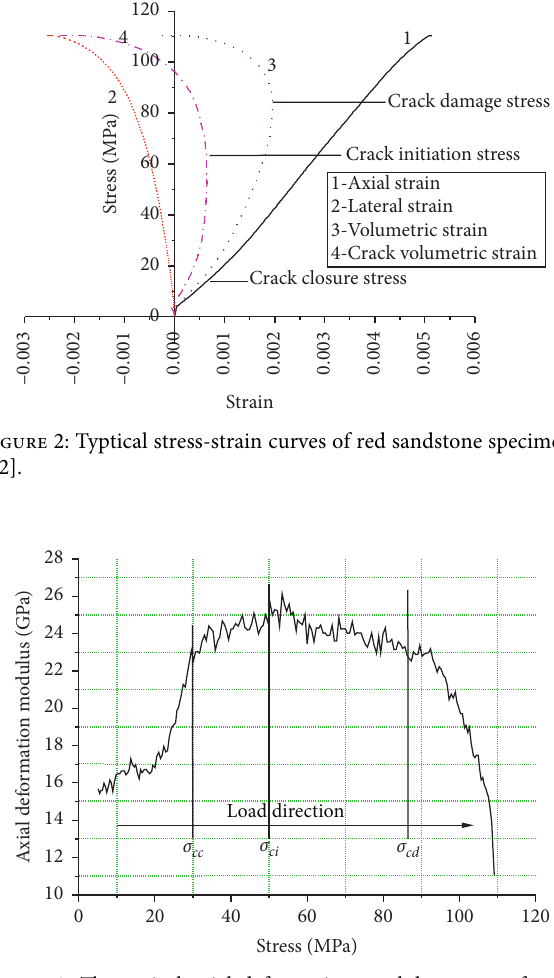
Figure 3: The typical axial deformation modulus curve of a red sandstone specimen.